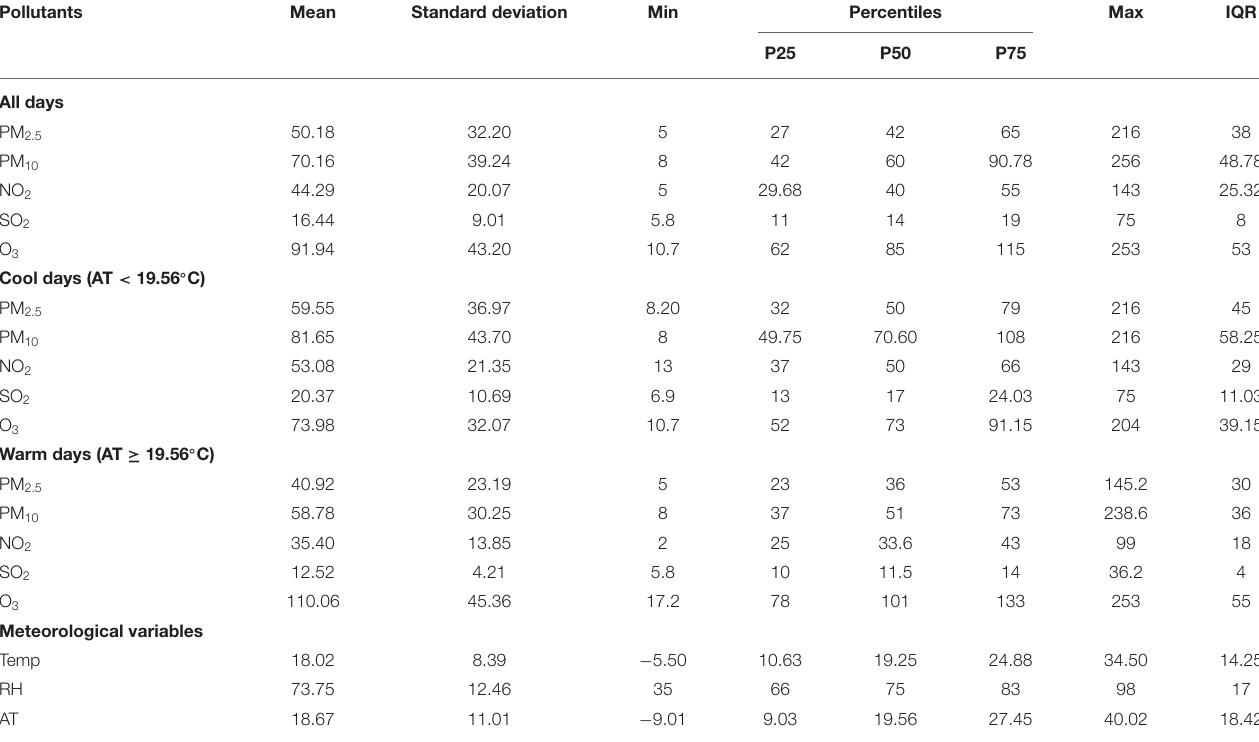
TABLE 2 | Summary statistics of air pollutants and meteorological variables in Shanghai,